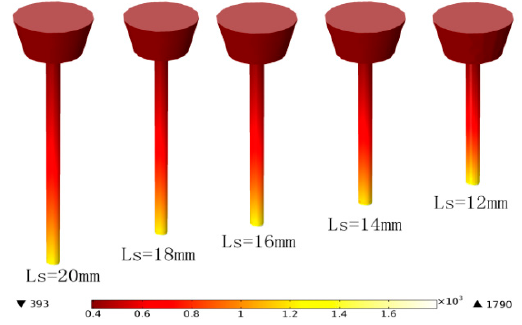
Sensors 2017 , 17 , 591